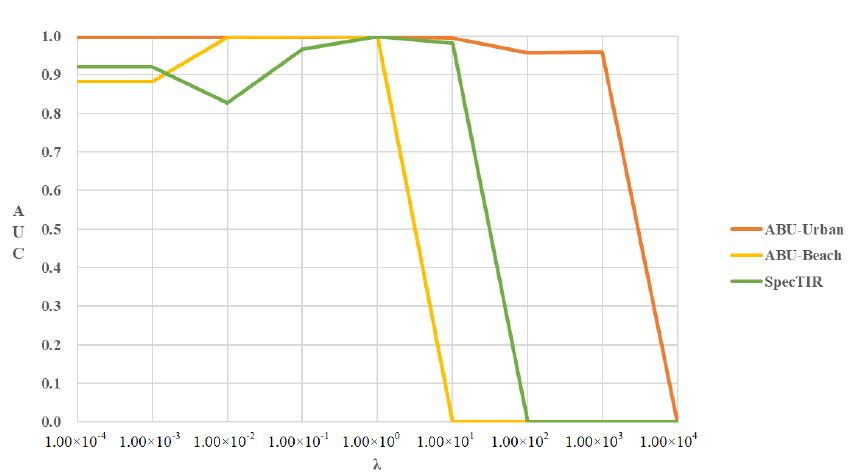
Figure 11. Tuning C of the proposed LRSNCR.